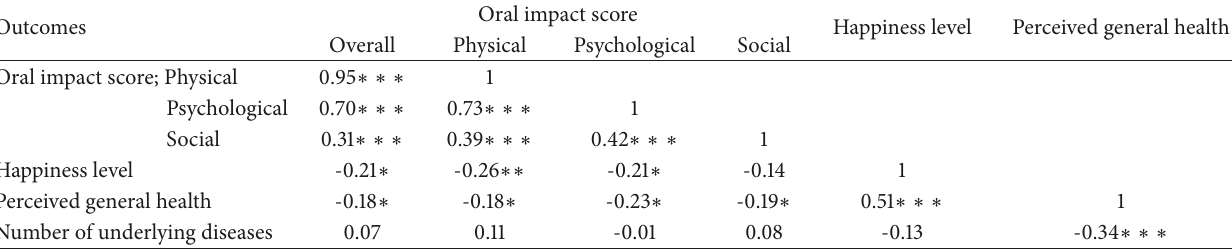
Table 5: Spearman correlation coefficient of the scores of oral impact, happiness, and perceived general